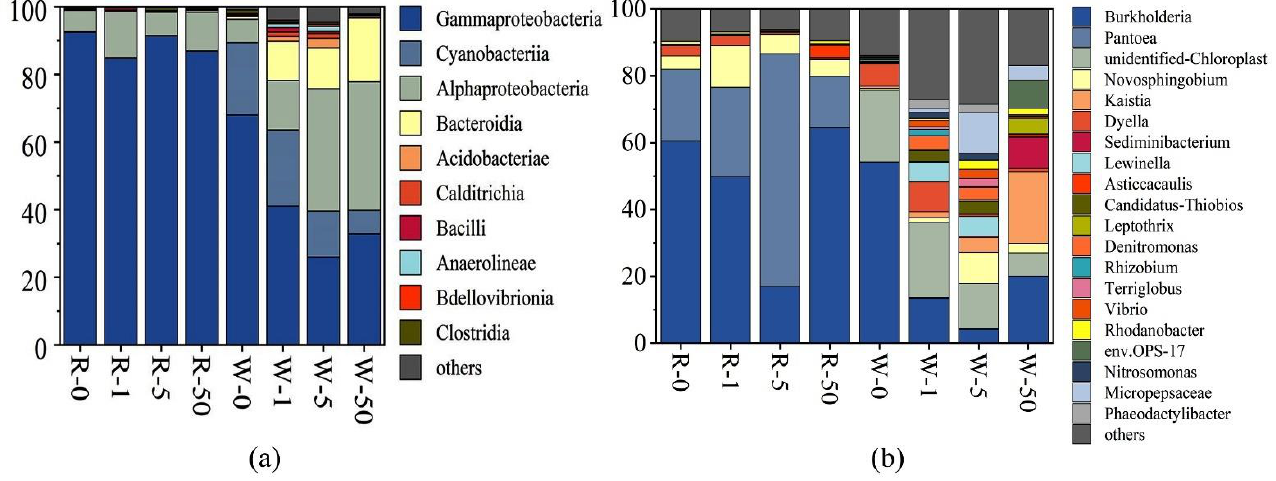
Figure 5. Microbial population dynamics in different treatments. Relative abundance of the top 10 classes ( a ). Relative abundance of the top 20 genera ( b ).